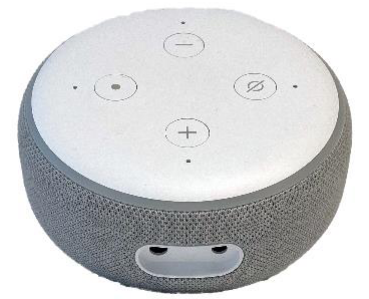
Figure 10. Echo Dot (3rd Gen)—Smart speaker with Alexa.